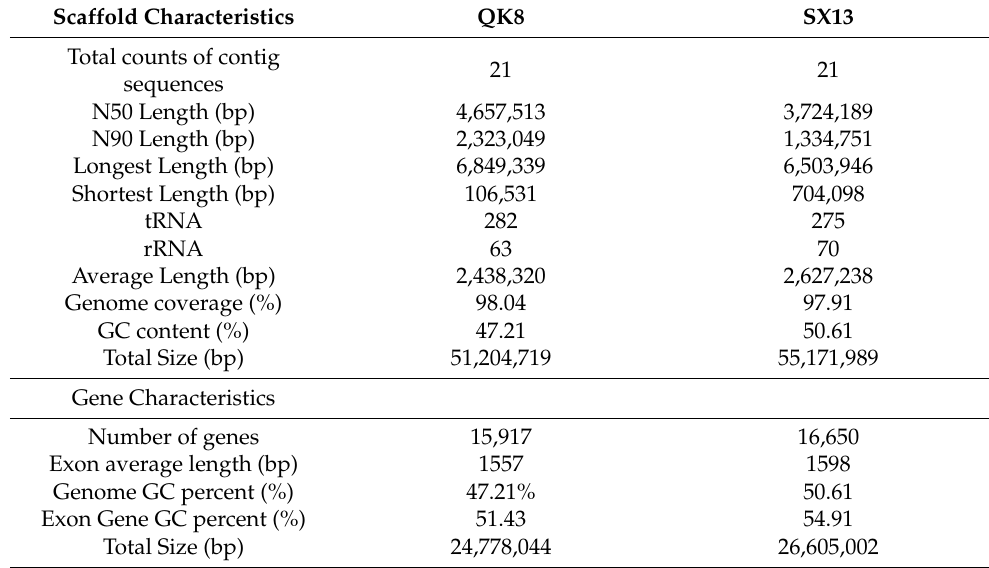
Table 1. General genomic features of the two Fusarium